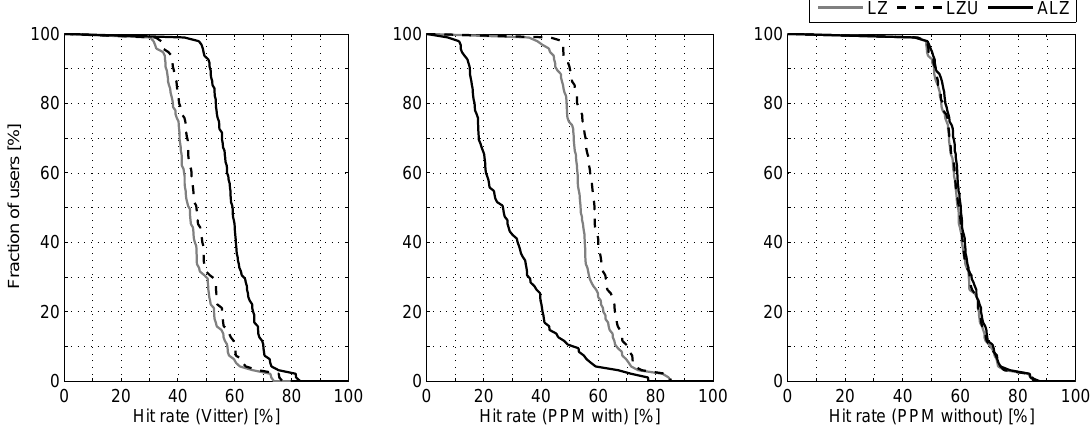
Figure 6. Comparison of hit rate attained when fixing the probability calculation method and varying the tree updating